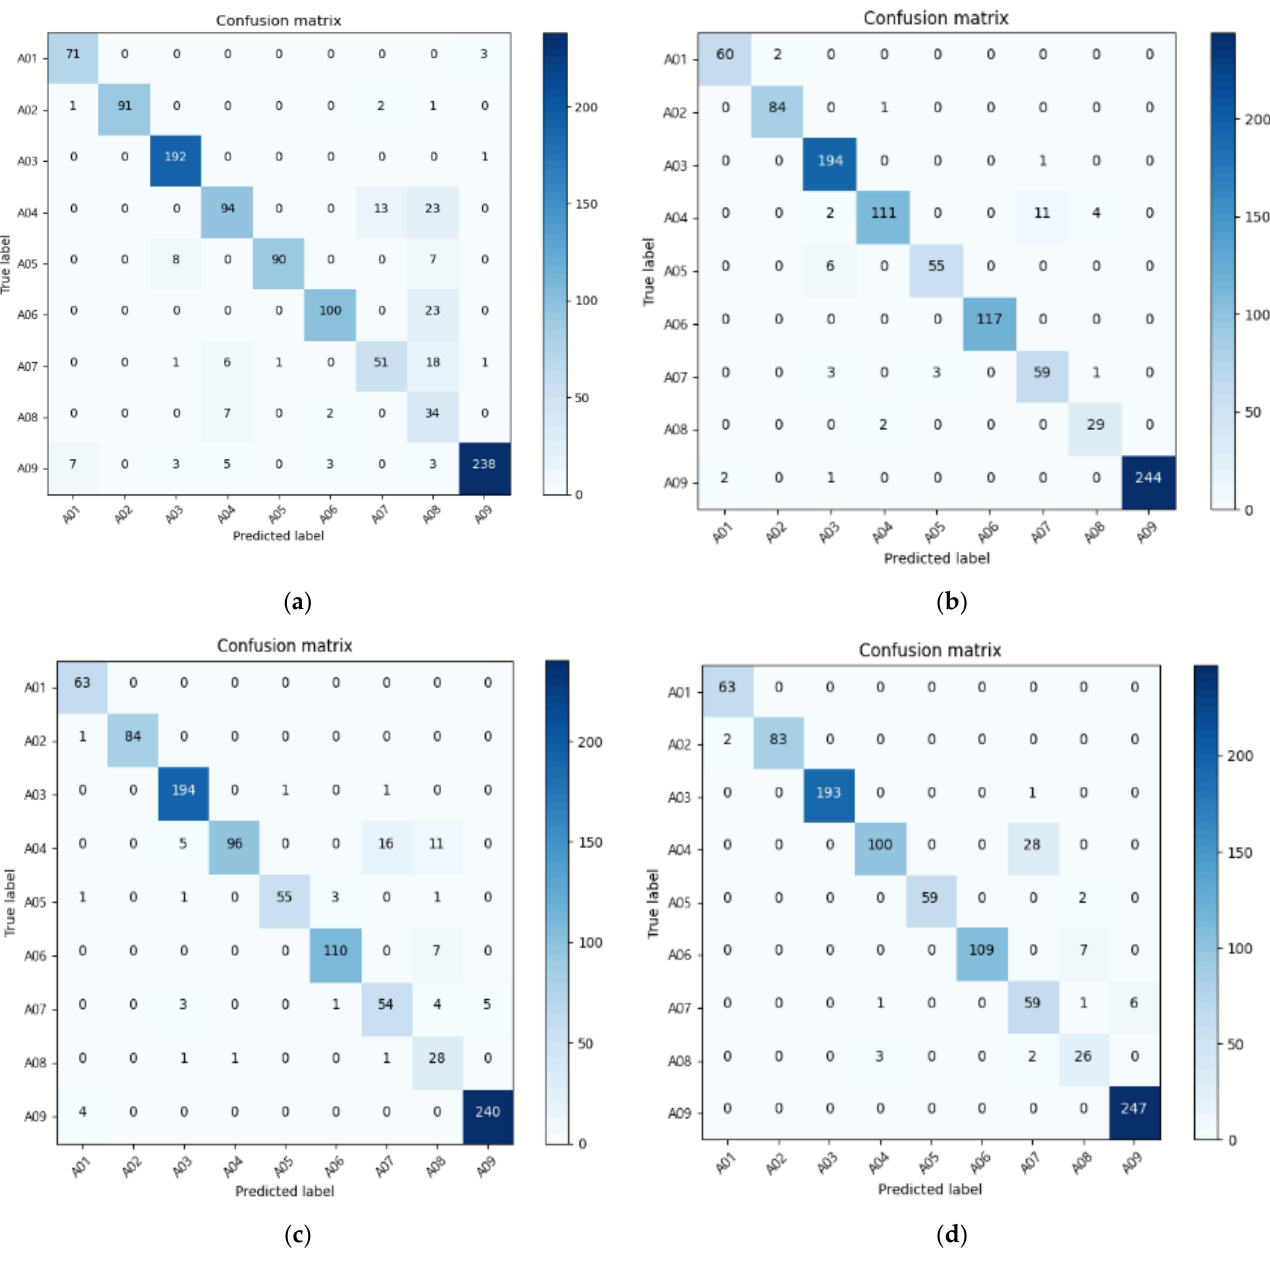
Figure 6. Confusion matrix of activity classification: ( a ) sensor-only confusion matrix, ( b ) accelerome- ter and skeleton image, ( c ) skeleton coordinates and accelerometer, and ( d ) accelerometer, skeleton vector, and skeleton